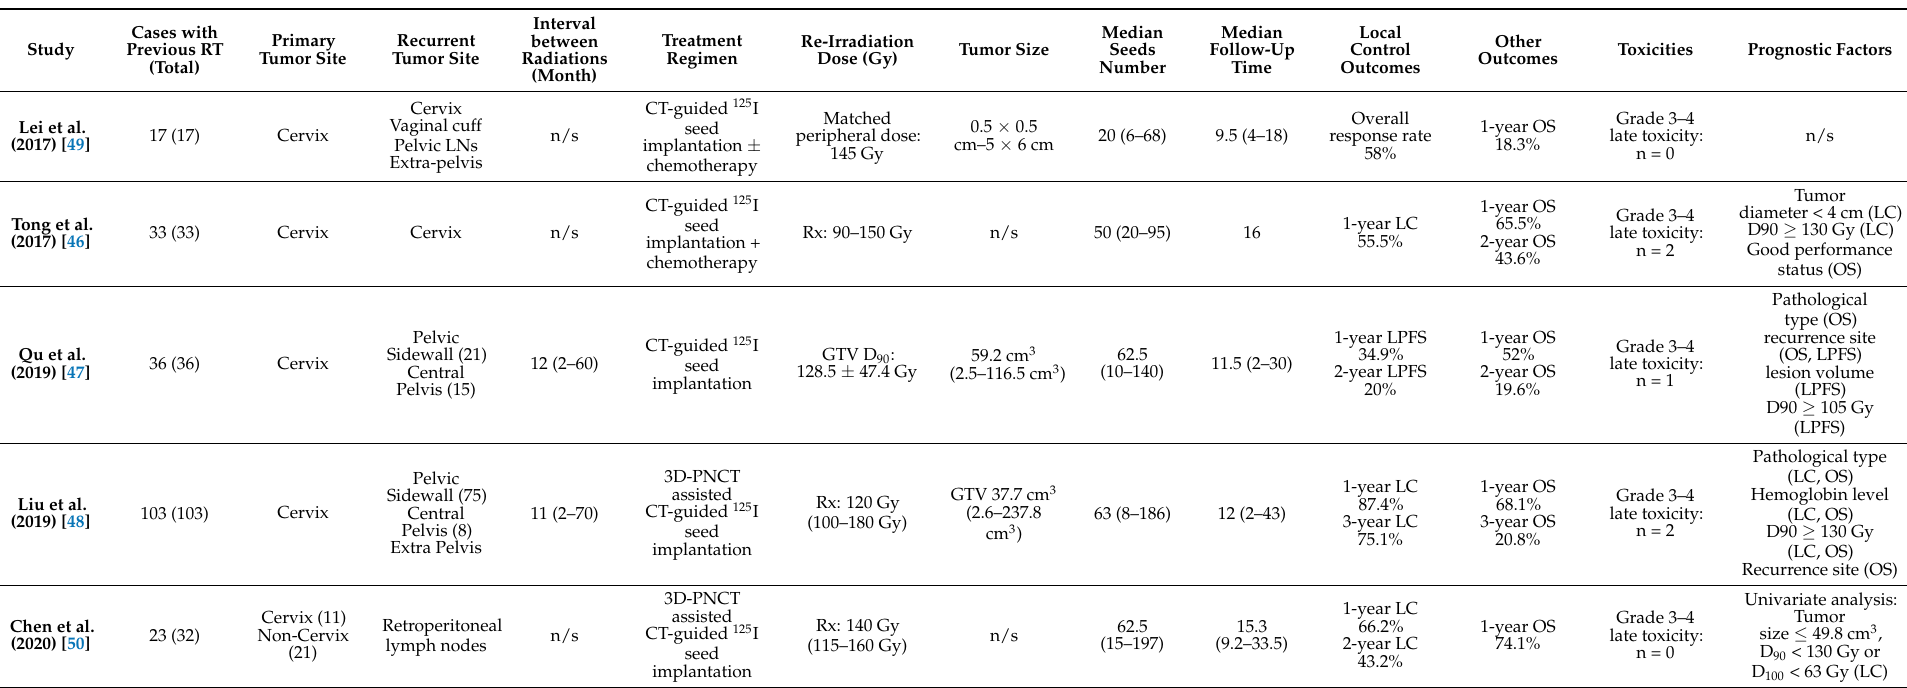
Table 2. Recent studies on re-irradiation with PRSI for recurrent cervical